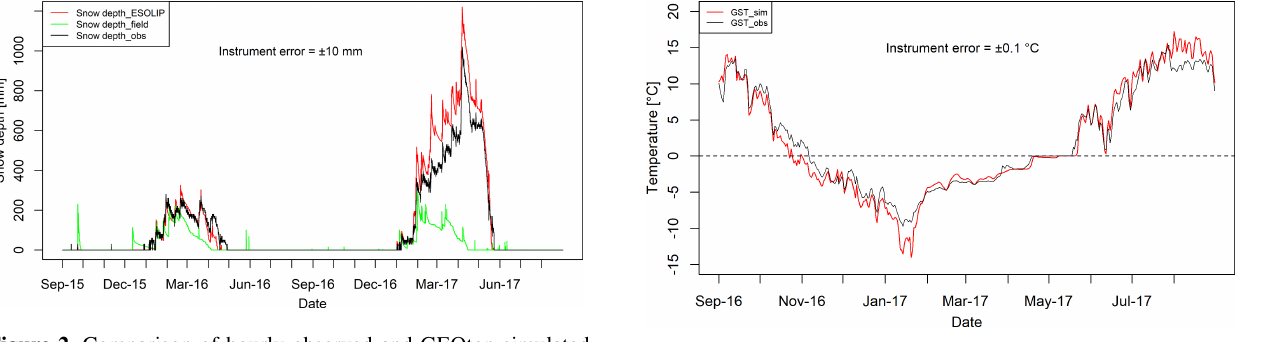
Figure 3. Comparison of daily mean observed (GST_obs; ◦ C) and GEOtop-simulated near-surface ground temperature (GST_sim; ◦ C) at South Pullu (4727ma.s.l.) from 1 September 2016 to 31 Au- gust